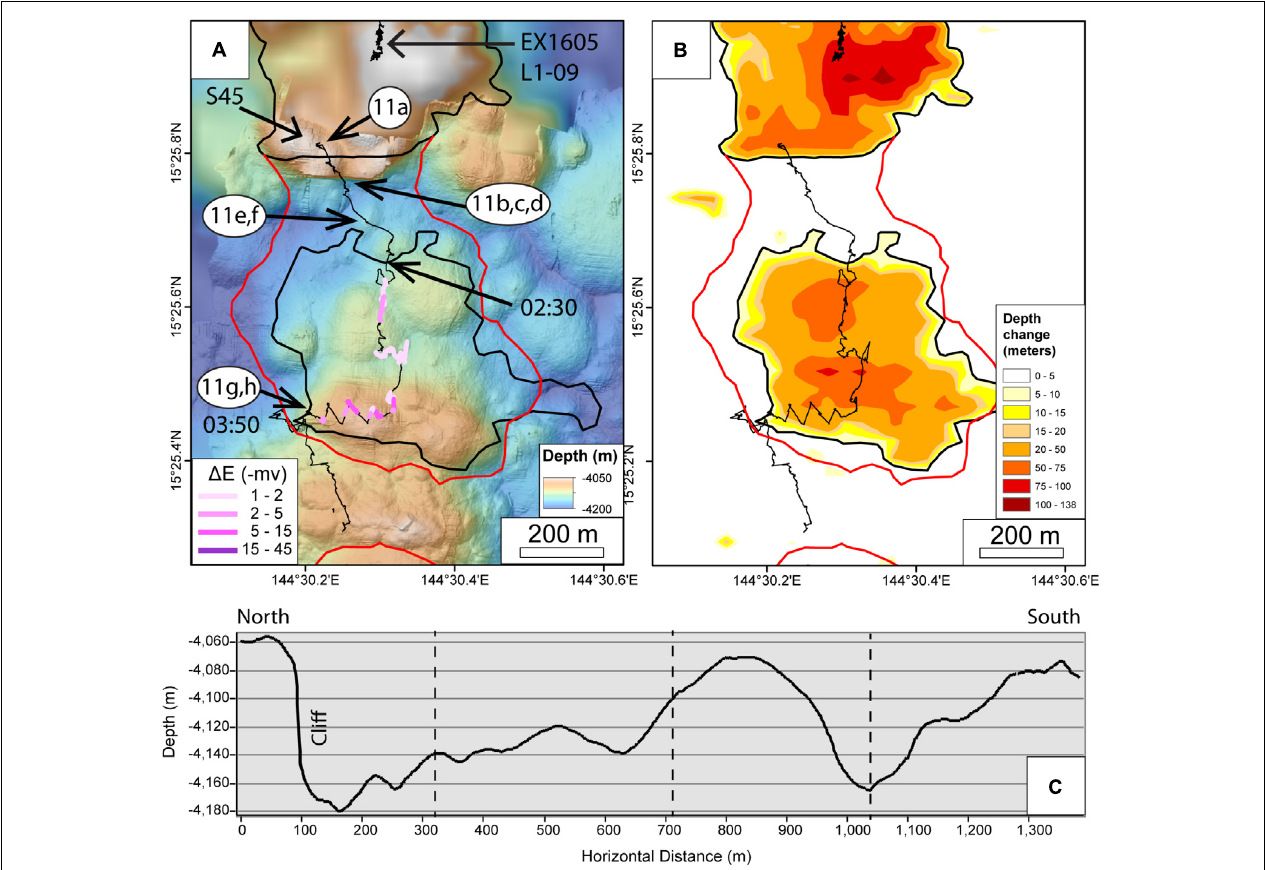
FIGURE 10 | Detailed maps showing the track of ROV SuBastian dive S45 (thin black squiggly line), which crossed parts of the northern 2013–2015 lava flows. Thicker black outlines are areas of depth change from ship bathymetry; red outlines are interpreted edge of new lava, based on dive observations and AUV bathymetry. (A) Bathymetric map, mostly AUV Sentry bathymetry (1-m resolution), except at northern and western edges where it is ship bathymetry (40-m resolution). Pink to purple colored lines overlain on dive track show (cid:49) E anomalies from MAPR instrument on ROV (see inset for scale). Labeled times (02:30 and 03:50) show beginning and end of MAPR time-series data in Figure 12 . Arrows with numbers show locations of ROV images in Figure 11 . The arrow pointing to the location of Figure 11b–d is the location of the nearly vertical cliff mentioned in the text. (B) Depth changes between ship-based bathymetric surveys in 2013–2015 with ROV dive track overlain. (C) Depth profile along ROV dive S45 track line, showing pillow mounds ( Sentry bathymetry). Vertical dashed lines indicate major bends in the dive